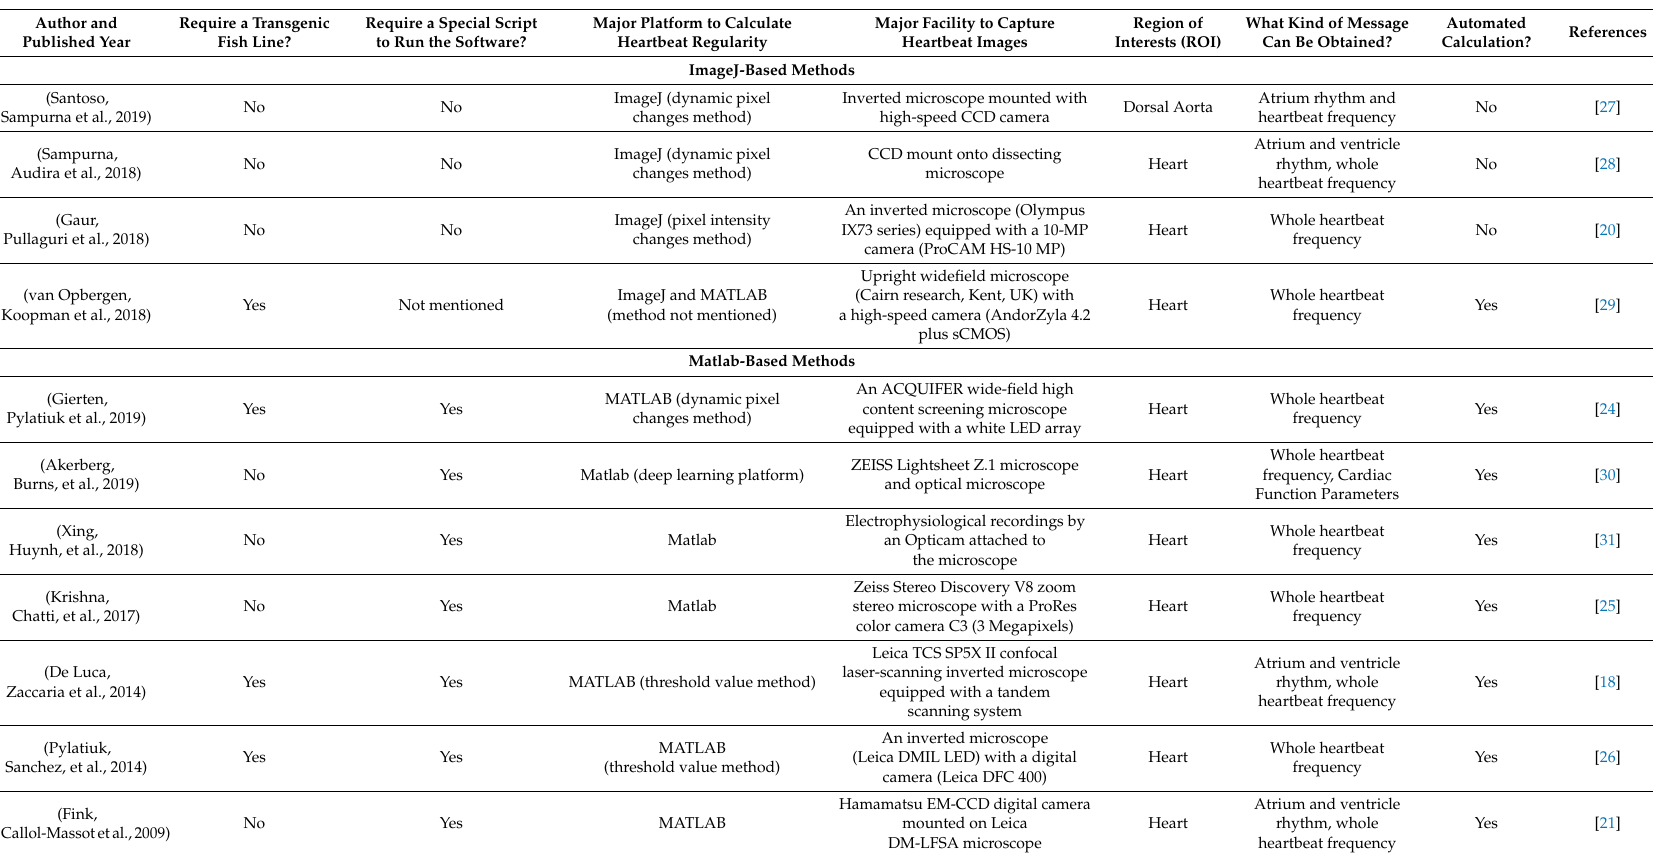
Table 1. Comparison of the methods for cardiac rhythm detection in zebrafish